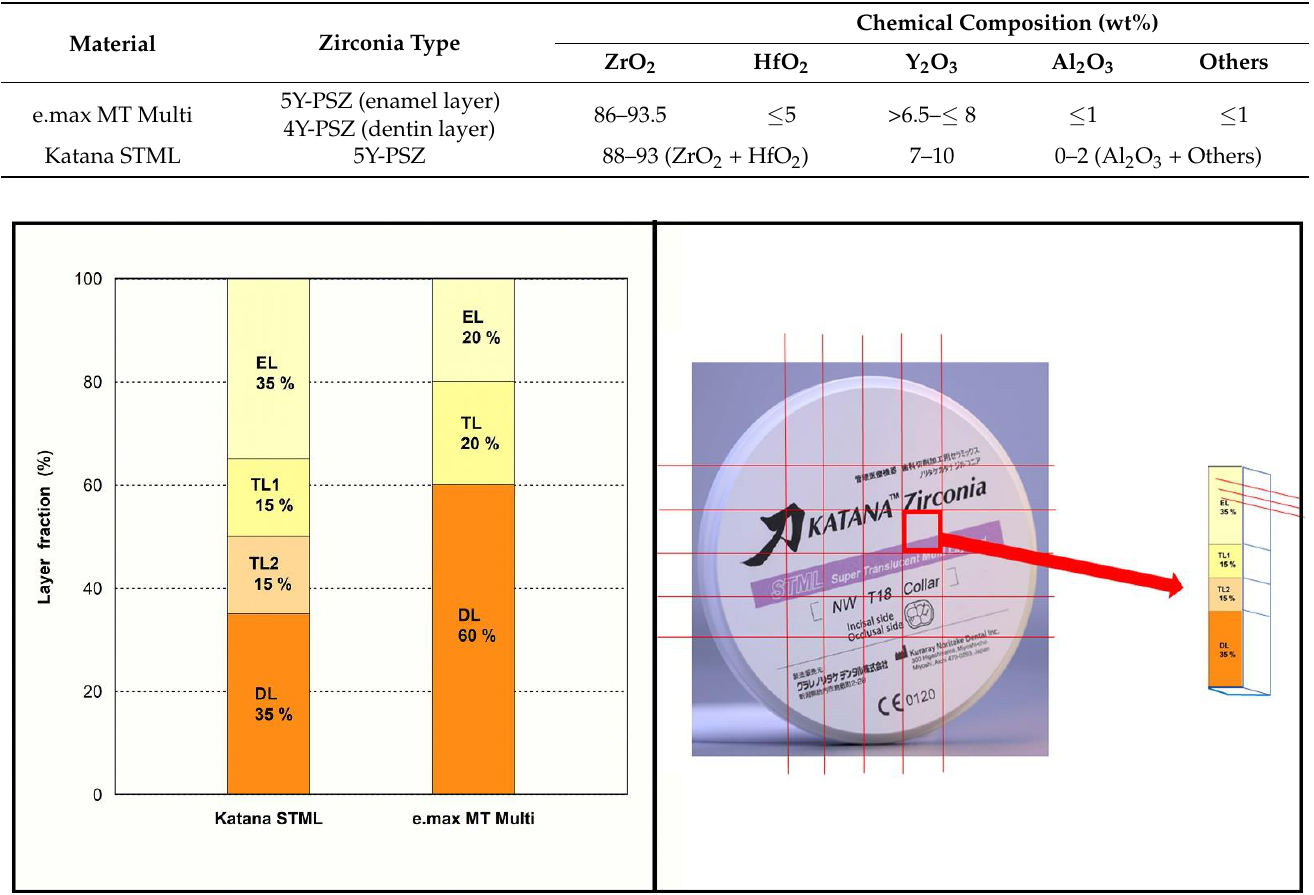
Table 1. Chemical composition of the materials used.